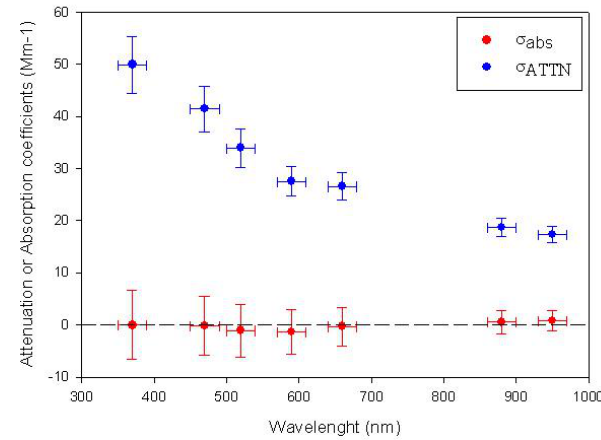
Fig. 4. Wavelength dependence of measured attenuation ( σ ATTN ) and the retrieved absorption ( σ abs )